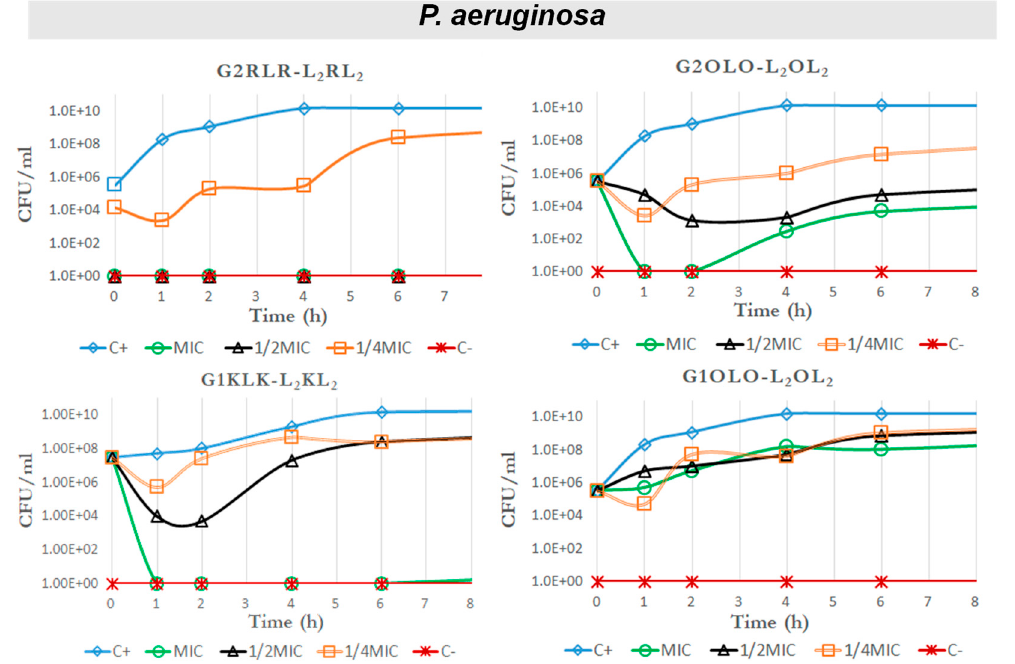
Figure 6. Time–kill curves against P. aeruginosa for G2RLR-L 2 RL 2 , G2OLO-L 2 OL 2 , G1KLK-L 2 KL 2 and G1OLO-L 2 OL 2 .